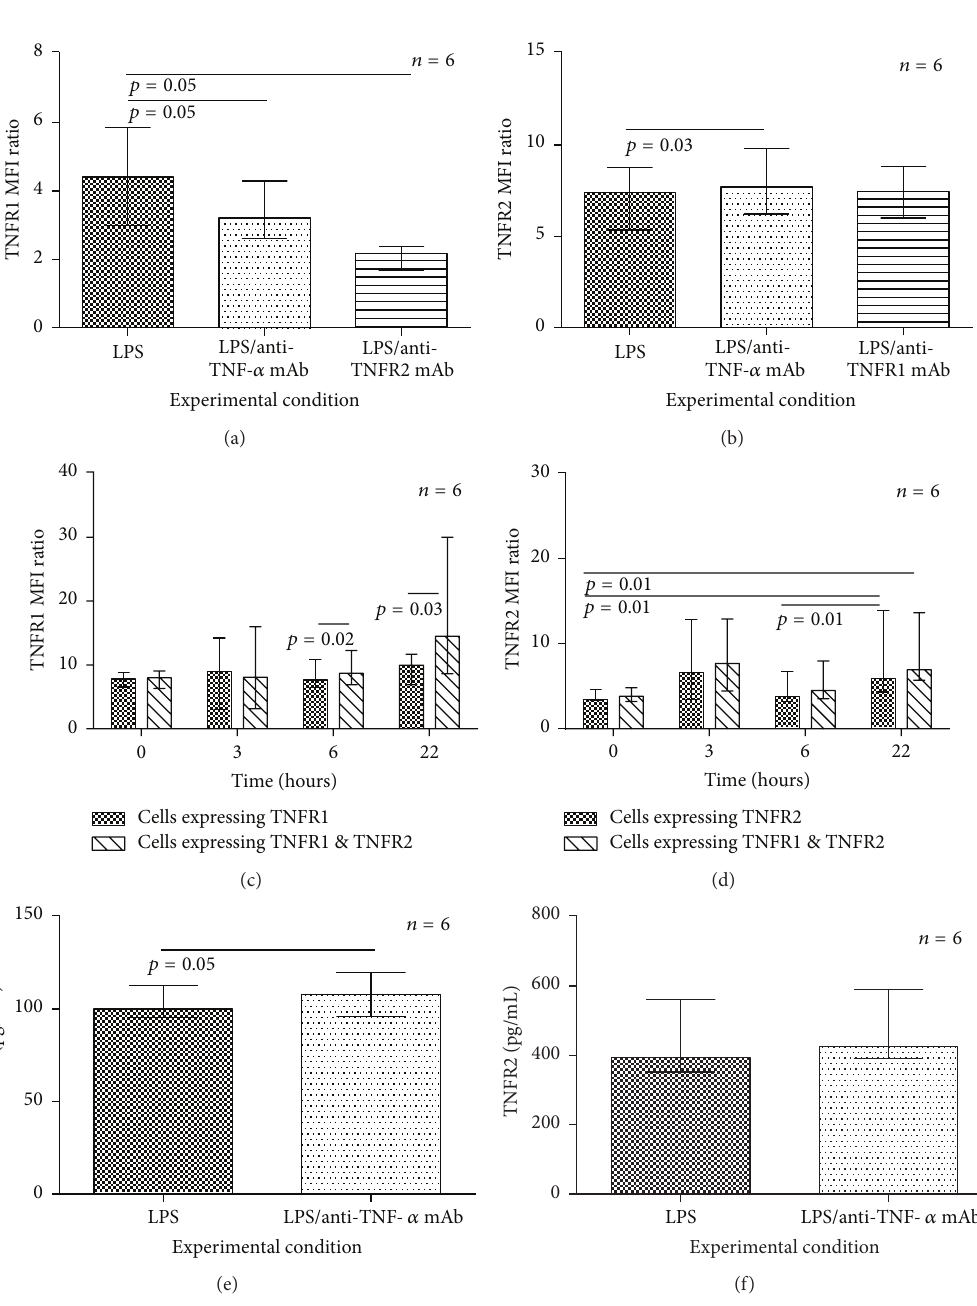
Figure 4: Autocrine effects of TNF- 𝛼 on TNF- 𝛼 receptor cell surface expression and soluble receptor concentration. In (a) and (b), the surface expression of TNFR1 and TNFR2 on monocytes stimulated with LPS (100ng/mL) ± TNF- 𝛼 mAb or selective TNF- 𝛼 receptor blockade (25 𝜇 g/mL) for 20 hours was determined (e.g., TNFR1 expression was determined in monocytes where TNF- 𝛼 signalling via TNFR2 had been prevented with a blocking mAb). Concentrations were compared to LPS-stimulated cells, using a Wilcoxon Signed-Ranks Test. In (c) and (d), time course profiles of TNFR1 MFI and TNFR2 MFI, respectively, are shown in LPS-stimulated monocytes expressing one or both types of receptor. No overall difference was observed for time course profiles of TNFR1 expression in cells expressing solely TNFR1 (Friedman’s 𝑝 = 0.33 ) nor cells expressing both receptors (Friedman’s 𝑝 = 0.09 ). Friedman’s test was significant for TNFR2 expression in cells expressing TNFR2 solely ( 𝑝 = 0.02 ) and cells expressing both receptors ( 𝑝 = 0.02 ). Significant post hoc pairwise comparisons 𝑝 values are shown in the figures. Differences in MFI at each time point between cell types were assessed with a Wilcoxon Signed-Ranks Test. In (e) TNFR1 and (f) TNFR2, the columns show the concentration in the supernatant of LPS-stimulated monocytes (for 22 hours) ± TNF- 𝛼 mAb (10 𝜇 g/mL). Concentrations were compared to the positive control, LPS-stimulated cells, using a Wilcoxon Signed-Ranks Test. Columns in all figures show median (IQR) values. The experiments represent data from 6 subjects. Experimental conditions/time points for flow cytometry analyses were conducted in duplicate (a–d) with the exception of freshly isolated monocytes (time: 0 hours) in (c) and (d) due to limitations to cell numbers available. Experimental conditions in (e) and (f) were conducted in culture wells in duplicate and in each sample run in duplicate on the subsequent